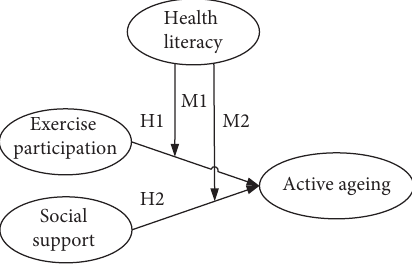
Figure 1: Research